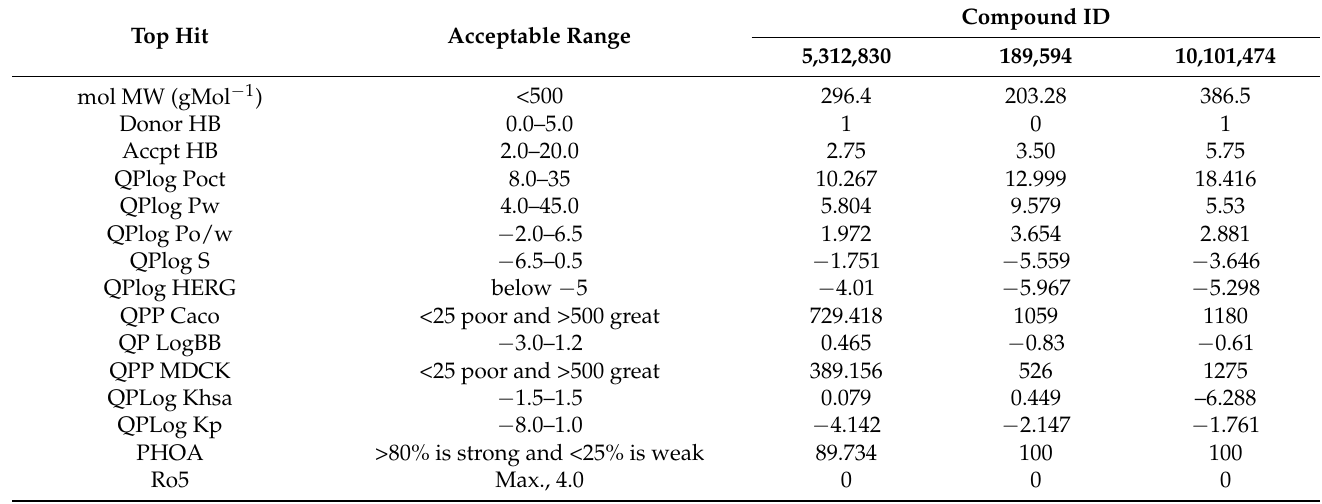
Table 2. Estimated physiochemical and pharmacokinetic parameters by QikProp for compounds selected compounds.